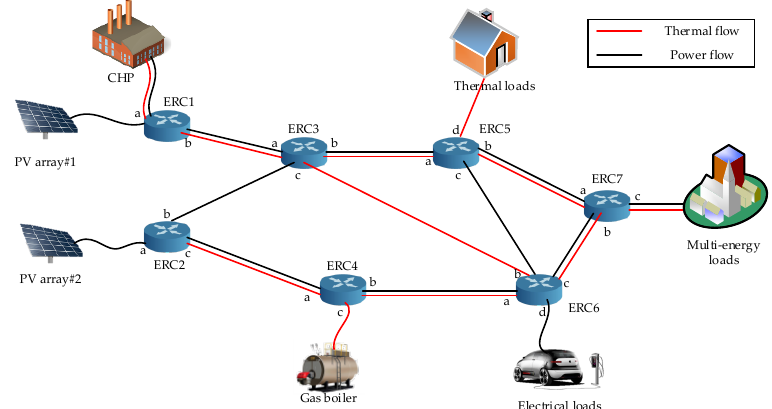
Figure 5. Diagram of energy routing design.